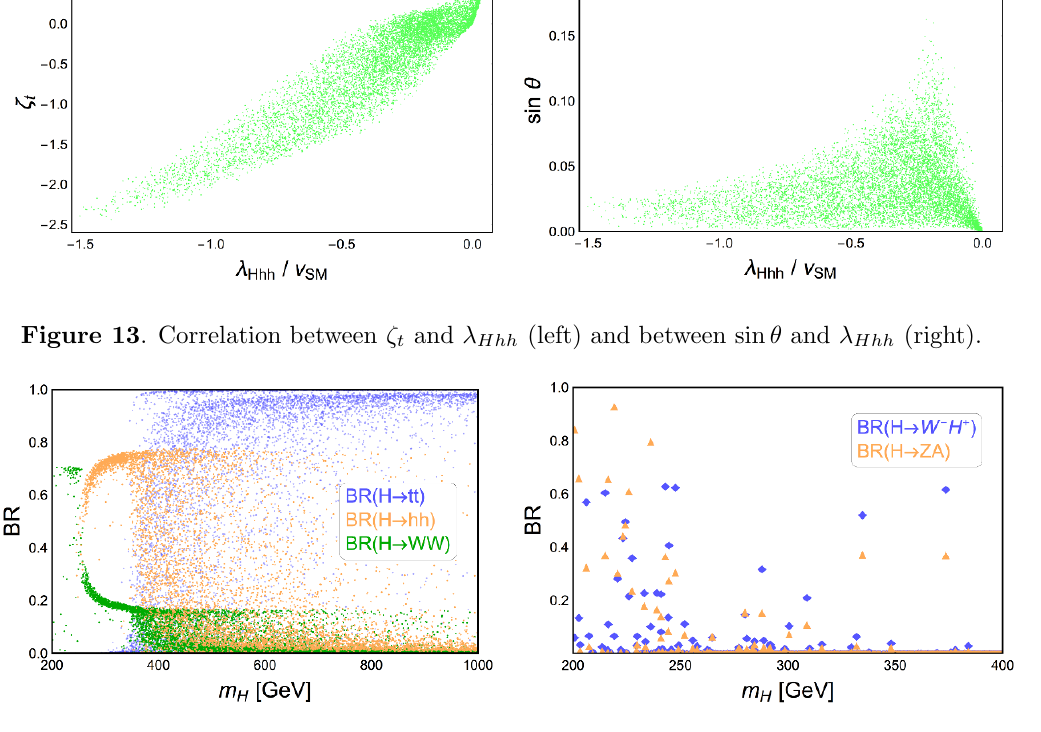
Figure 14 . (Left) The BRs of the H state in the t (cid:22) t (blue), hh (orange) and W + W (cid:0) (green) channels. (Right) The BRs of H into W (cid:0)(cid:3) H + (blue) and Z (cid:3) A (orange). For readability, we refrain from presenting here BR( H ! ZZ ): in virtue of eq. (6.13) this is about half that of BR( H ! W + W (cid:0)